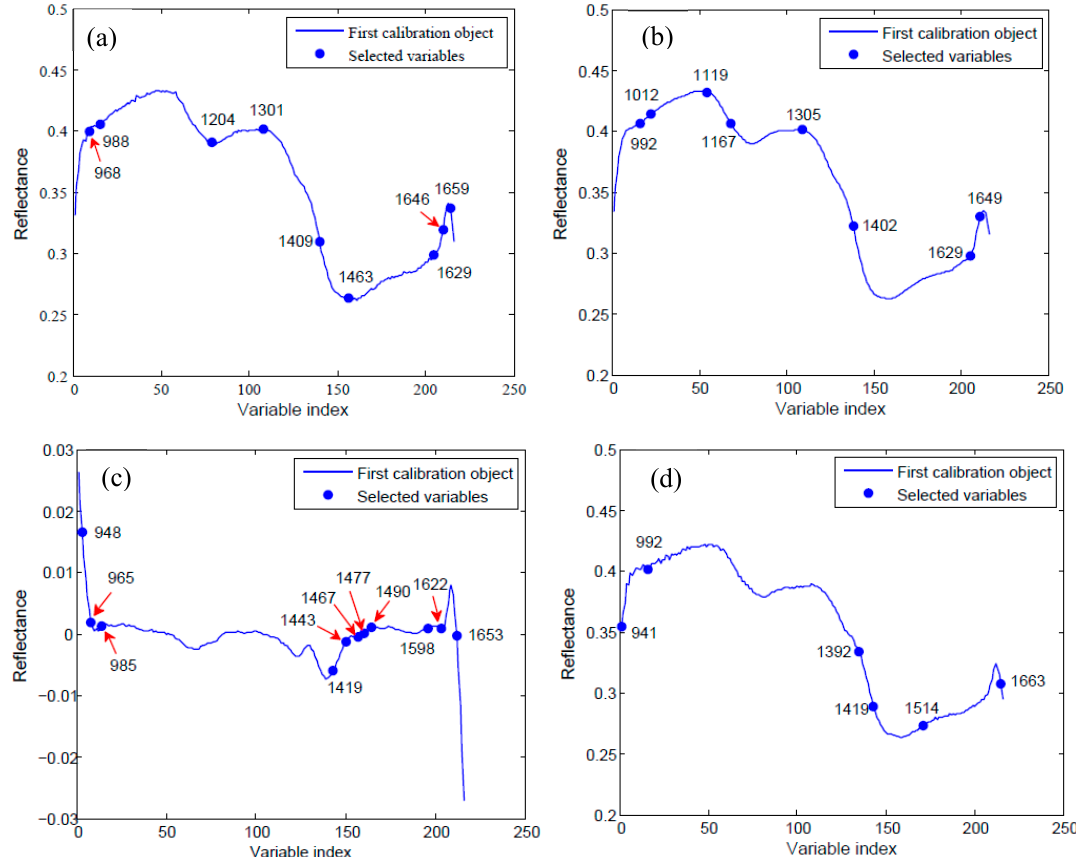
Figure 4. Selection of optimal wavelengths by successive projections algorithm (SPA). Distributions of important variables (marked with ‘filled circle’) for ( a ) raw data and preprocessed data of ( b ) SG, ( c ) SG-D1 and ( d ) MSC.